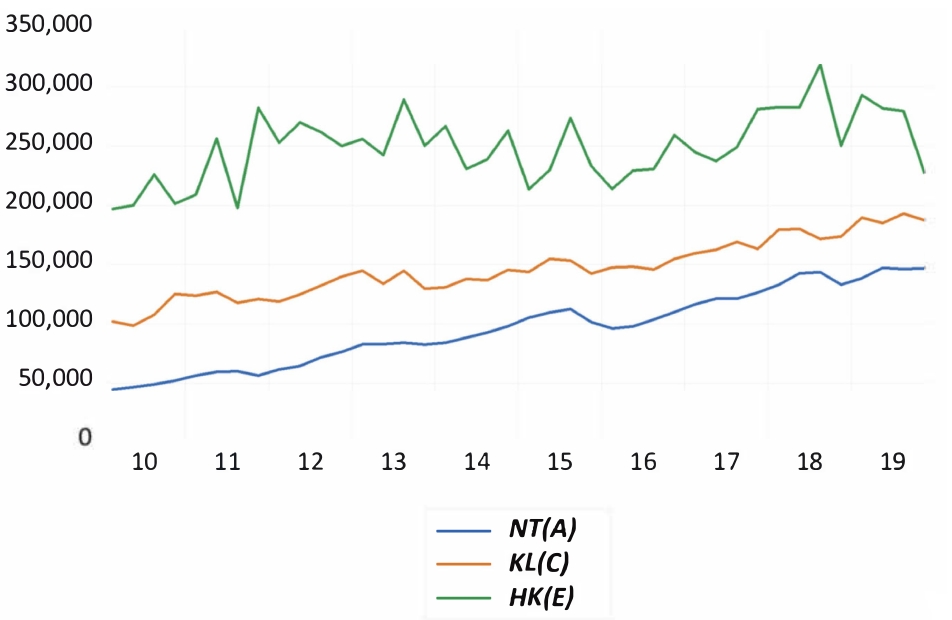
Figure 1. Average price per m 2 of the three sample submarkets.